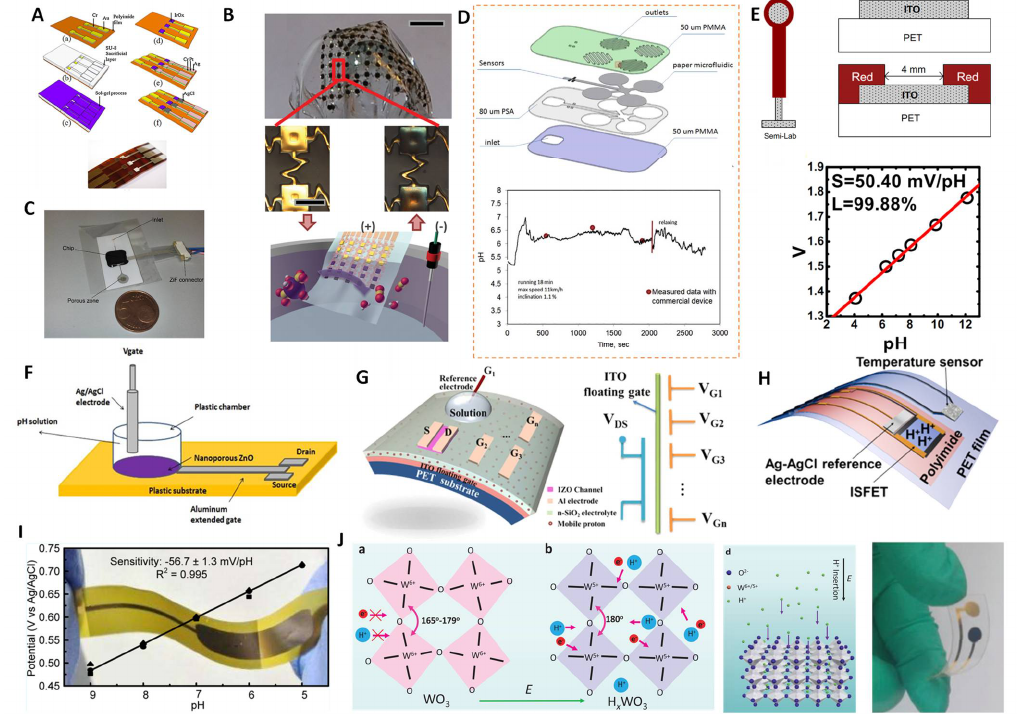
Figure 6. MO x −based wearable pH sensors. ( A ) The preparation process for IrO x −based flexible pH sensors. Reprinted with permission from [52], Copyright (2011) Elsevier. ( B ) Picture of thin compli- ant array of pH sensors. Reprinted with permission from [37], Copyright (2014) John Wiley and Sons publications. ( C ) Integrated silicon chip (with paper at the inlet for absorbing experiments). Re- printed with permission from [110], Copyright (2016) Elsevier. ( D ) Schematic representation of the fabrication steps of the micro-fluidic chip. The figure shows the real-time monitoring image of the human sweat pH value from the microfluidic chip. Reprinted with permission from [111], Copy- right (2017) Elsevier. ( E ) Schematic and cross−section of the ITO/PET electrode. The figure shows the pH linear response curve. Reprinted with permission from [112], Copyright (2012) Elsevier. ( F ) Flexible pH sensor based on extended gate transistor. Reprinted with permission from [97], Copy- right (2014) Elsevier. ( G ) Flexible pH sensor based on an IZO neuromorphic transistor with multiple gate electrodes. Reprinted with permission from [51], Copyright (2015) Spring Nature. ( H ) A wear- able ion-sensitive filed effect transistor (ISFET) integrating flexible pH and temperature devices. Reprinted with permission from [113], Copyright (2017) American Chemistry Society. ( I ) Flexible WO 3 −based pH sensor on metal substrate with −56.7 ± 1.3 mV/pH sensitivity. Reprinted with per- mission from [93], Copyright (2014) American Chemistry Society. ( J ) Structures of WO 3 before and after proton intercalation (H x WO 3 ). The image on the right shows a schematic of the insertion of a proton into the lattice of WO 3 and the photograph on the left shows the flexible electrode after pro- ton intercalation. Reprinted with permission from [109], Copyright (2022) John Wiley and Sons pub- lications. To solve this issue, Toonder et al. proposed a flexible and integrated microfluidic device based on a silicon chip [110] (Figure 6C). The filter integrated in the inlet part can absorb any liquid on the surface. The liquid then fills the microchannels and sensing cav- ity by capillary action. The integrated IrO x sensor chips showed a pH−sensitivity up to −61 ± 1 mV/pH; however, the standard electrode potential between different electrodes had a